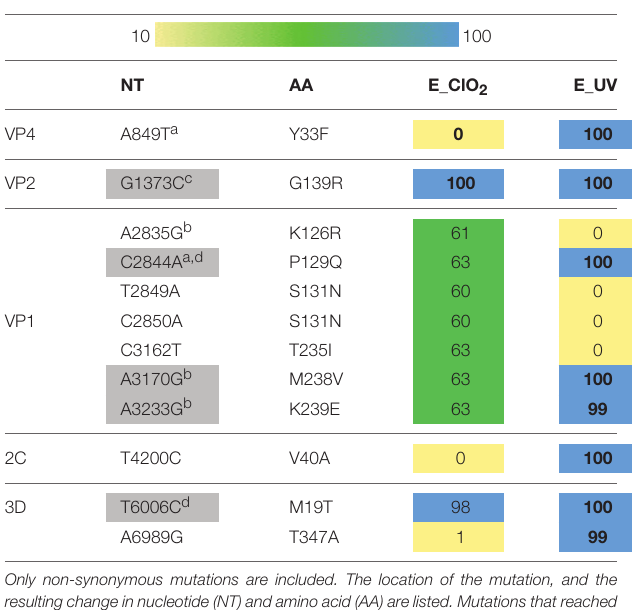
TABLE 1 | Heat map of the frequency of alleles that changed from minor to major or from major to fixed in the evolved populations E_ClO 2 and